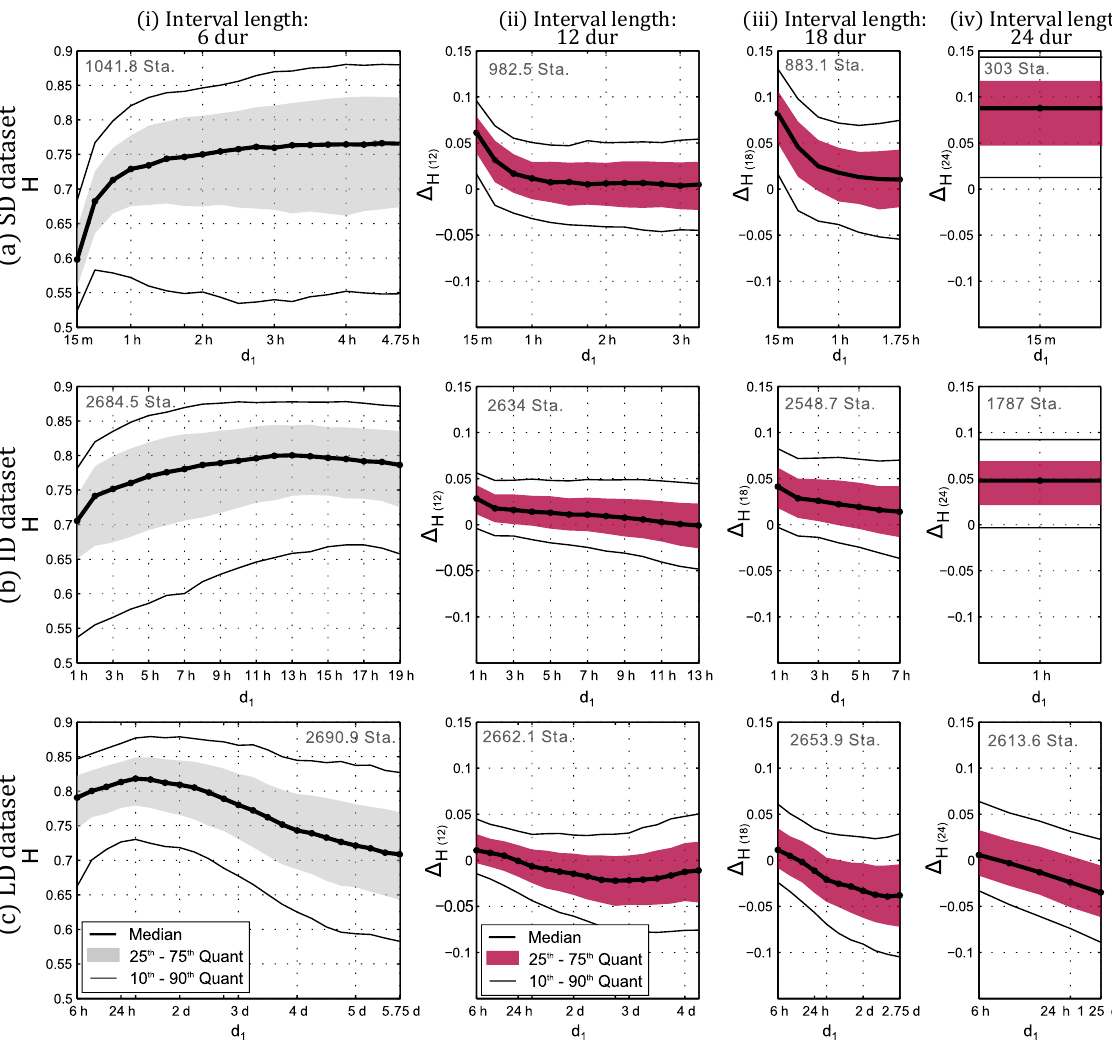
Figure 4. Column (i): median and relevant quantiles of the scaling exponent distribution over all valid SS stations for each 6-duration scaling interval. Column (ii)–(iv): median and relevant quantiles of the distribution of the scaling exponent deviation (cid:49) H average number of valid SS stations over the scaling intervals (identified by their first duration, d 1 ) is indicated at the top of each